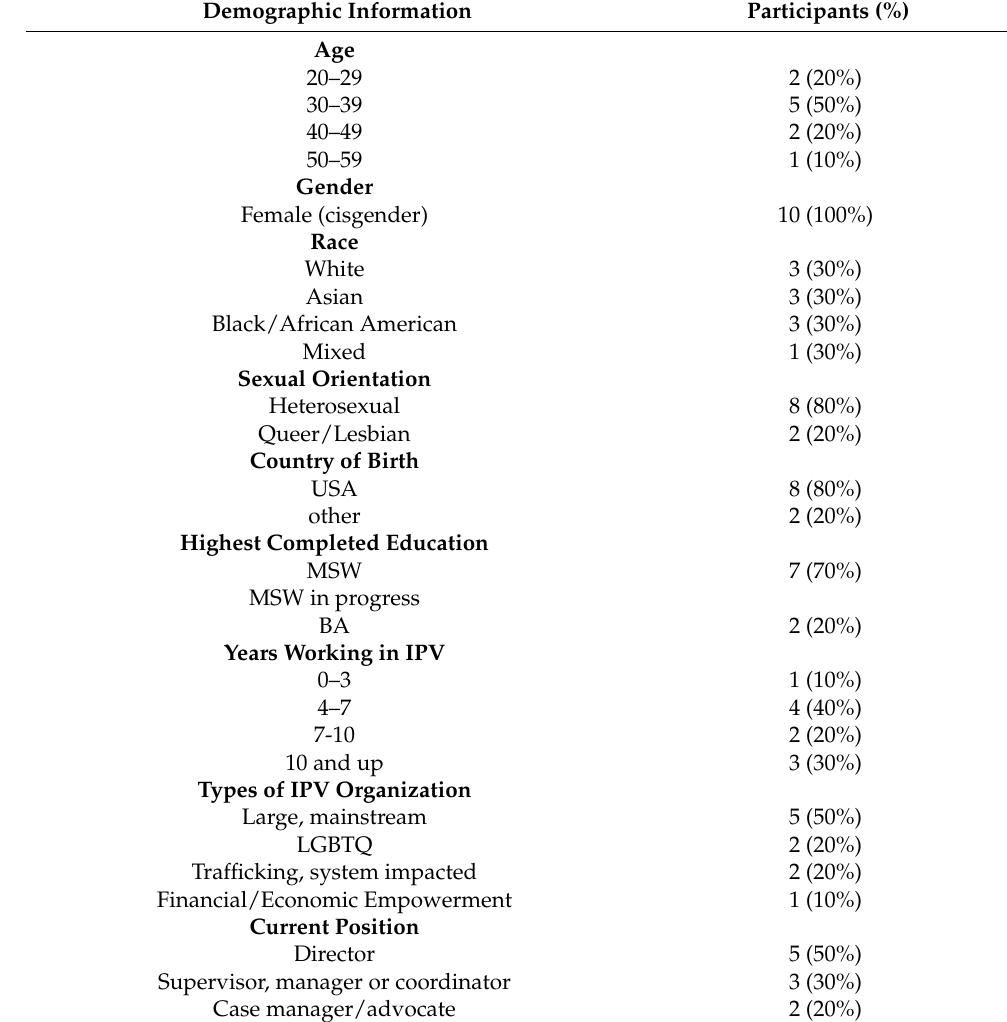
Table A2. IPV service provider